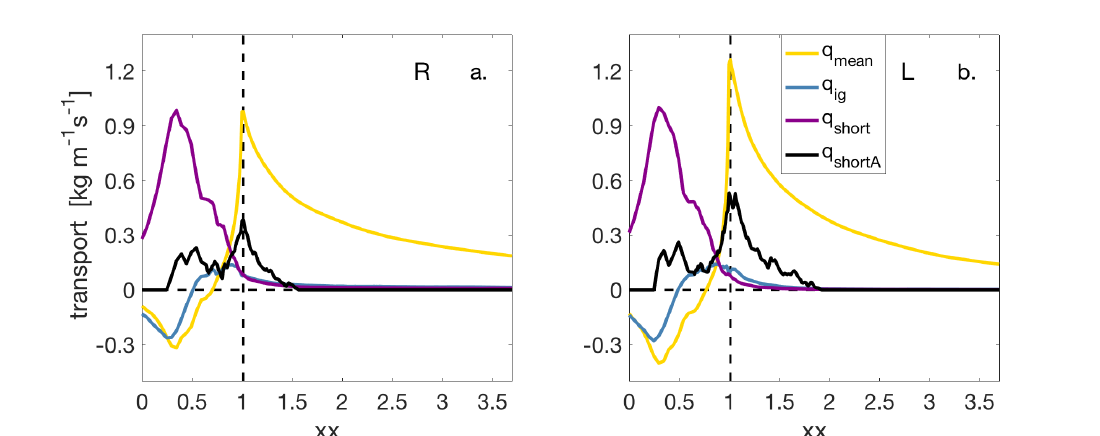
Figure 10. Transport processes q mean , q short , q ig , and q shortA are shown for reference case R ( a ) and case L ( b ) for which the water level at the ocean side was lowered by 0.5 m. The x -axis is the normalized grid ( xx ) from the beginning of the seaward slopes ( xx = 0) to the back barrier basin ( xx = 3.7). Here, the slopes are the same (1:120) and output at all grid locations is in the same water depth. The vertical dashed line indicates the location of the